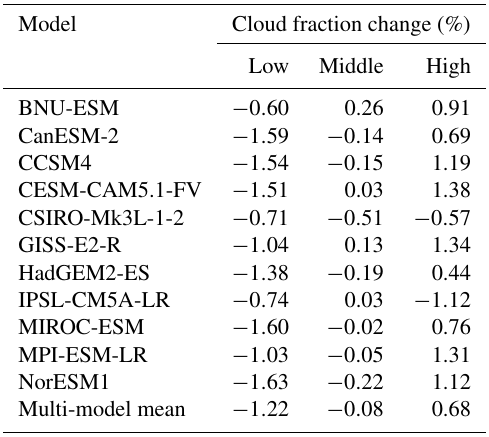
Table 2. Global mean changes in low, middle, and high cloud frac- tion in G1 –